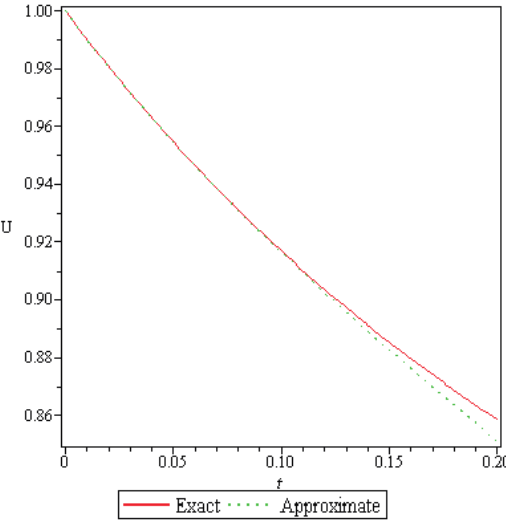
Fig. 4: Plots of U(x, t) vs. t at α = 1 and λ = 1 for exact solution and HASTM for Eqs.